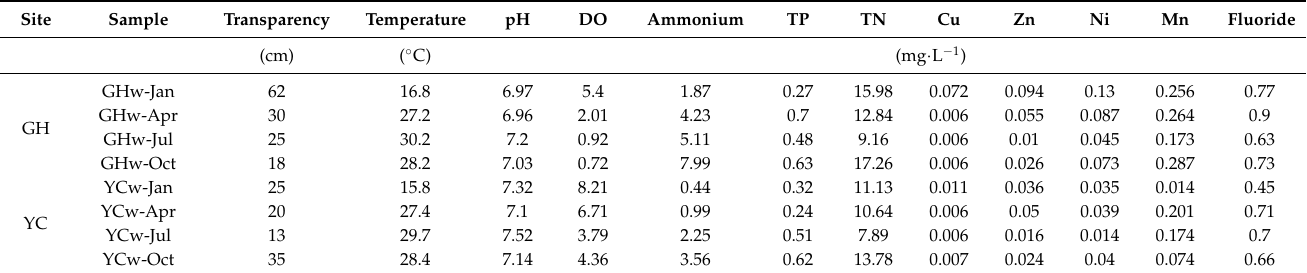
Figure 1. Map of the sampling sites in the Maozhou River. Table 1. Sampling sites and physicochemical properties of the